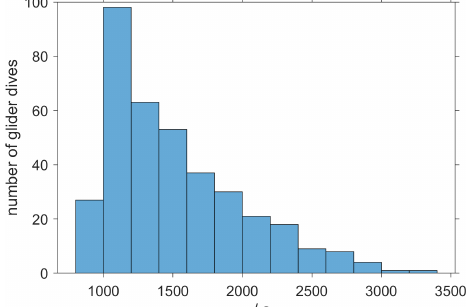
Figure 4. Panel (a) shows the calibrated p (CO 2 ) ( p cal (CO 2 )) in black and the discrete samples in azure. (b) Plot of p (CO 2 ) ver- sus depth where the continuous vertical lines are the mean every 50m and the error bars represent the standard deviation. Blue colour shows p u (CO 2 ) without any correction; red shows p d (CO 2 ) cor- rected for drift; green represents p c (CO 2 ) corrected for drift and lag; black shows p cal (CO 2 ) calibrated against water samples (azure dots) collected during the deployment (Sect. 2.5). p cal (CO 2 ) had a mean standard deviation of 22µatm and a mean bias of 1.8µatm compared with the discrete samples.